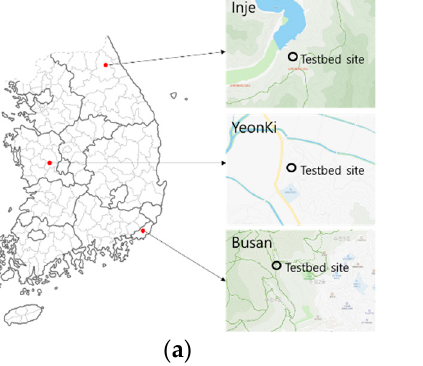
Figure 6. Testbed site: ( a ) location of testbed sites; ( b ) cross section of the installed sensor.